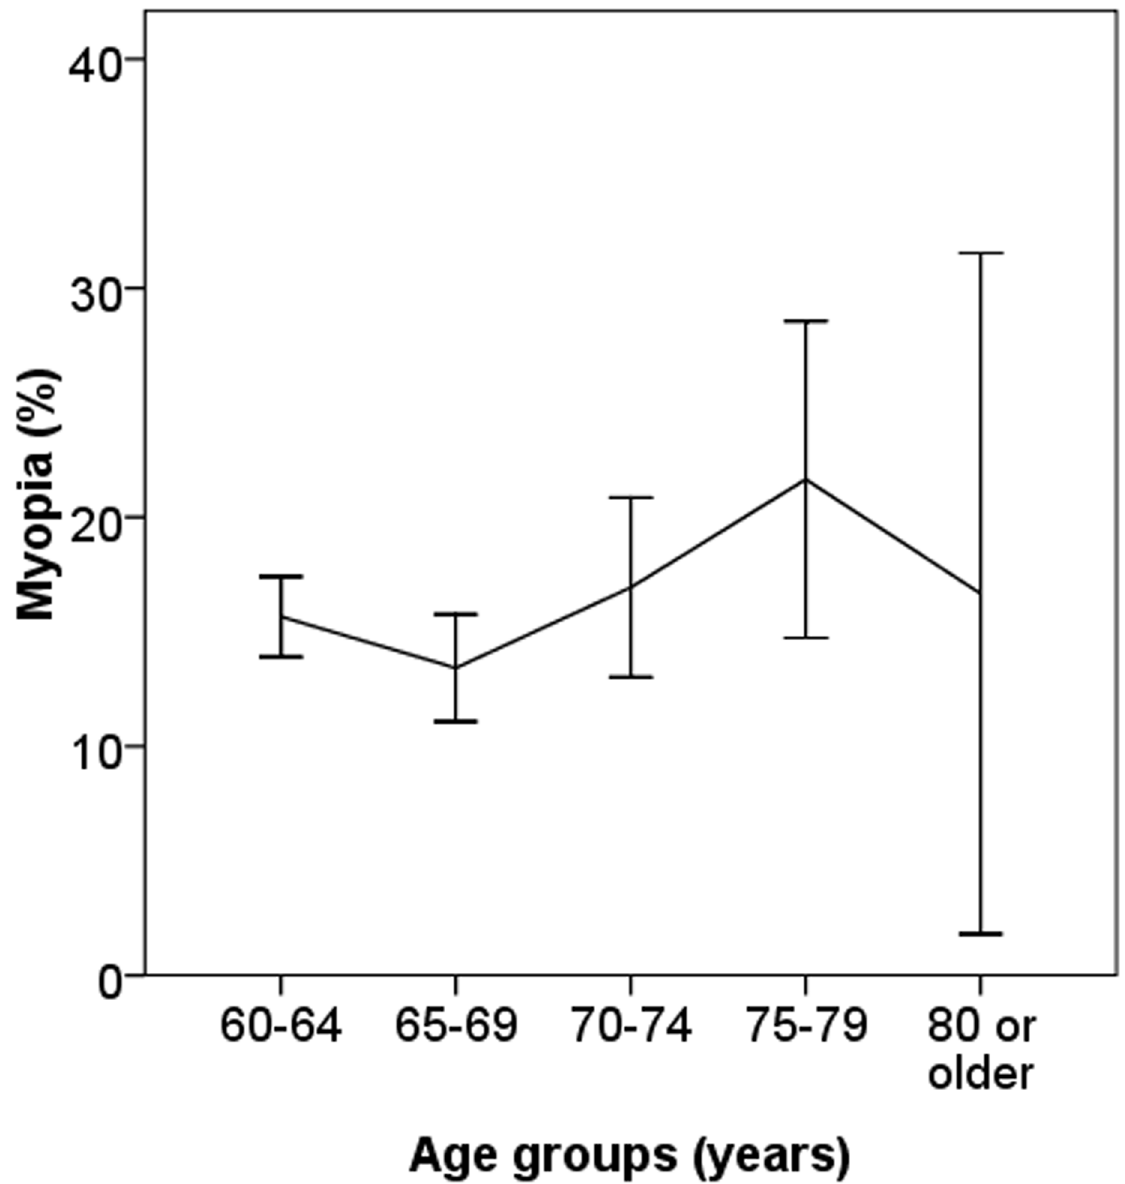
Fig 3. Age-specific prevalenceof myopia in participants without